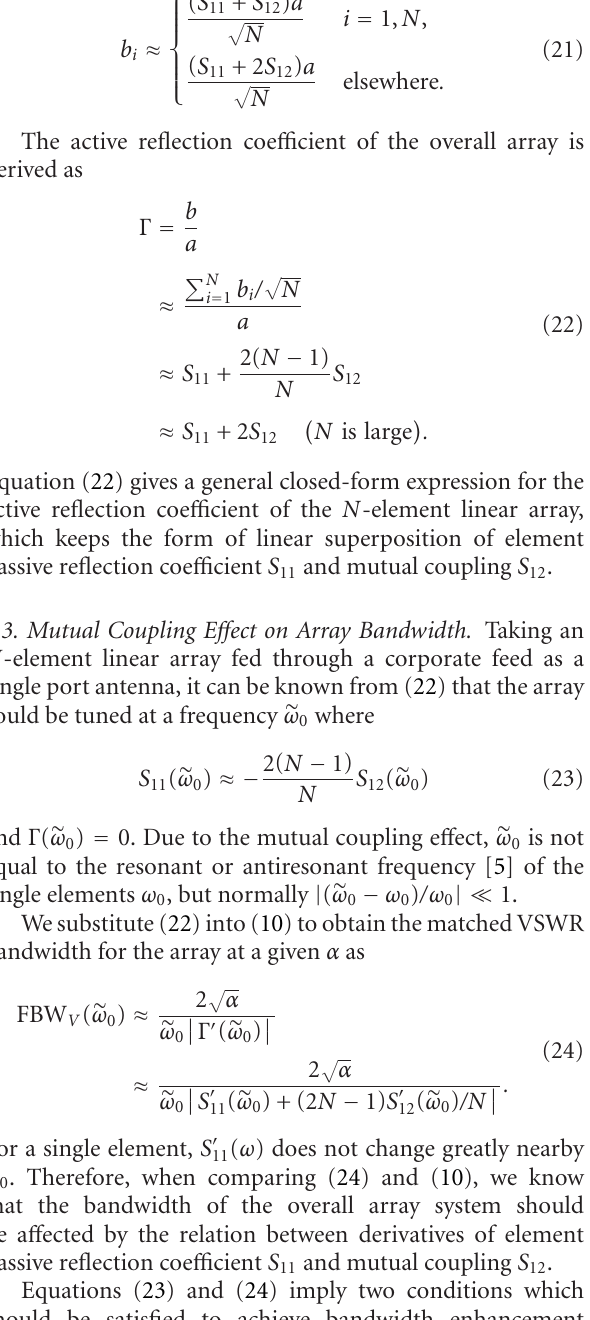
Figure 1: A two-element array fed through a T-branch power divider.